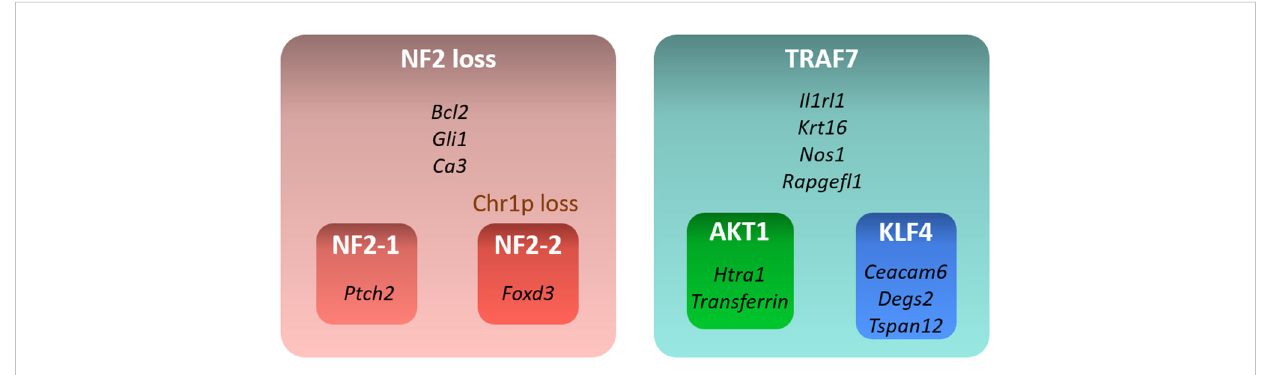
FIGURE 5 Summary of gene signatures for different benign meningioma subtypes. Only highly expressed and signi fi cant genes speci fi c for each subtype are